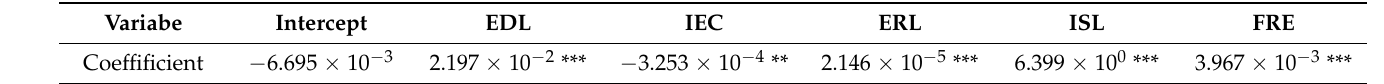
Table 4. Regression results of influencing factors.